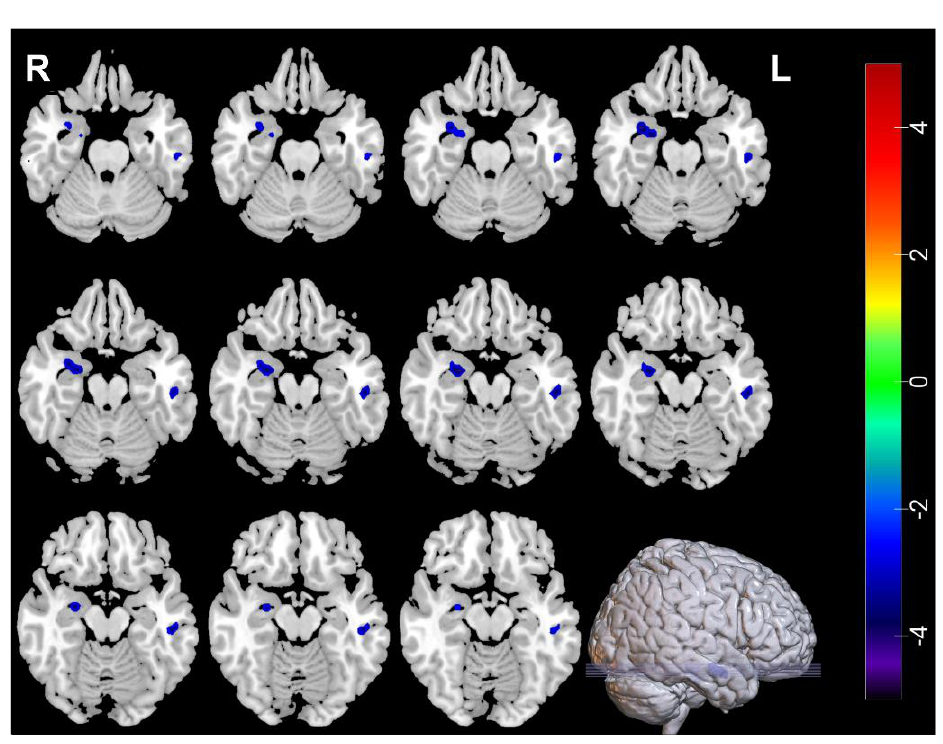
Table 4. Significant differences in ALFF and ReHo between MDDs and HCs.